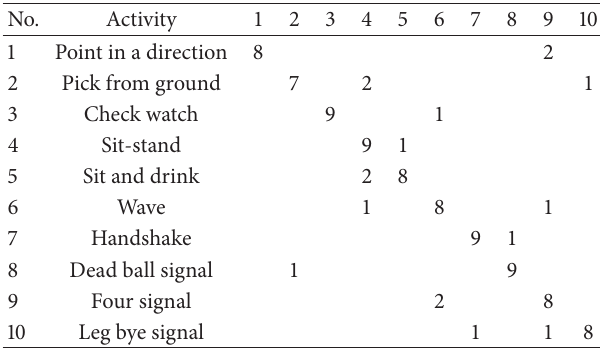
Figure 6: Flow diagram detailing the steps required to classify an incoming activity. Table 2: Confusion matrix for activity recognition when using all skeleton